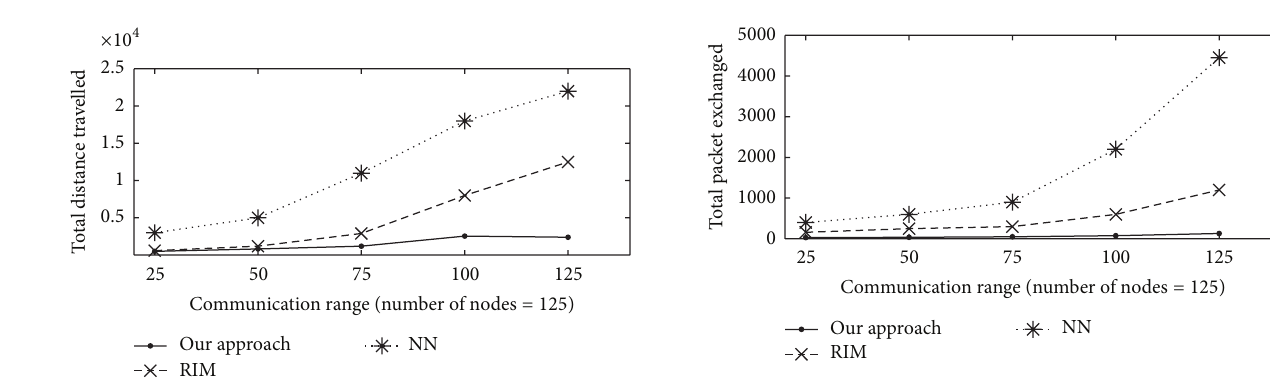
Figure 4: Total distance travelled by all nodes (meters) versus com- munication range (meters).